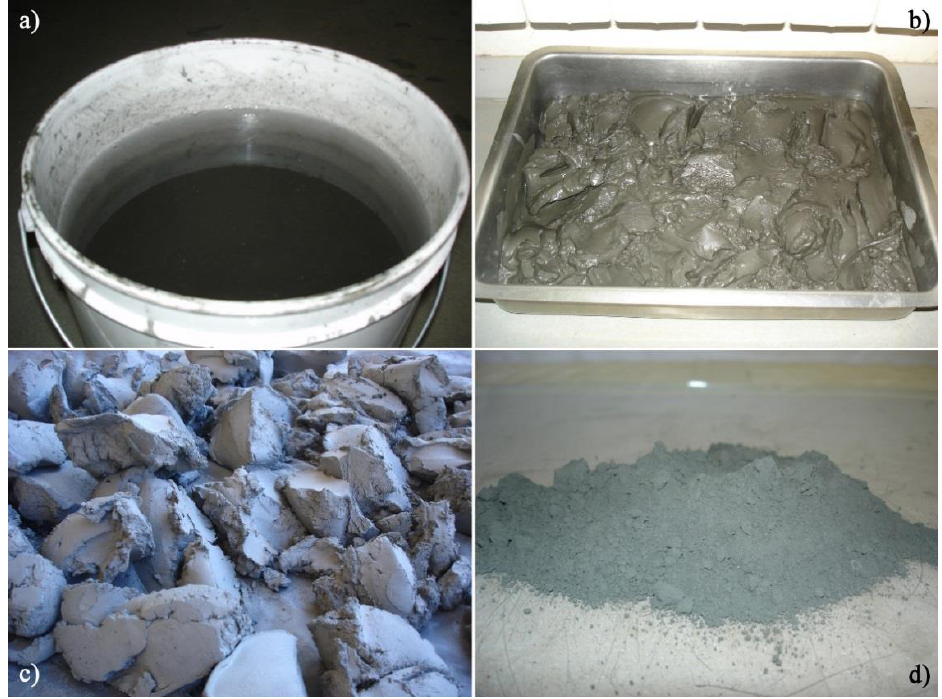
Figure 3. Tailings as received in the laboratory ( a ); after most of the water was removed ( b ); after drying in the oven ( c ); after breaking the clods ( d ).